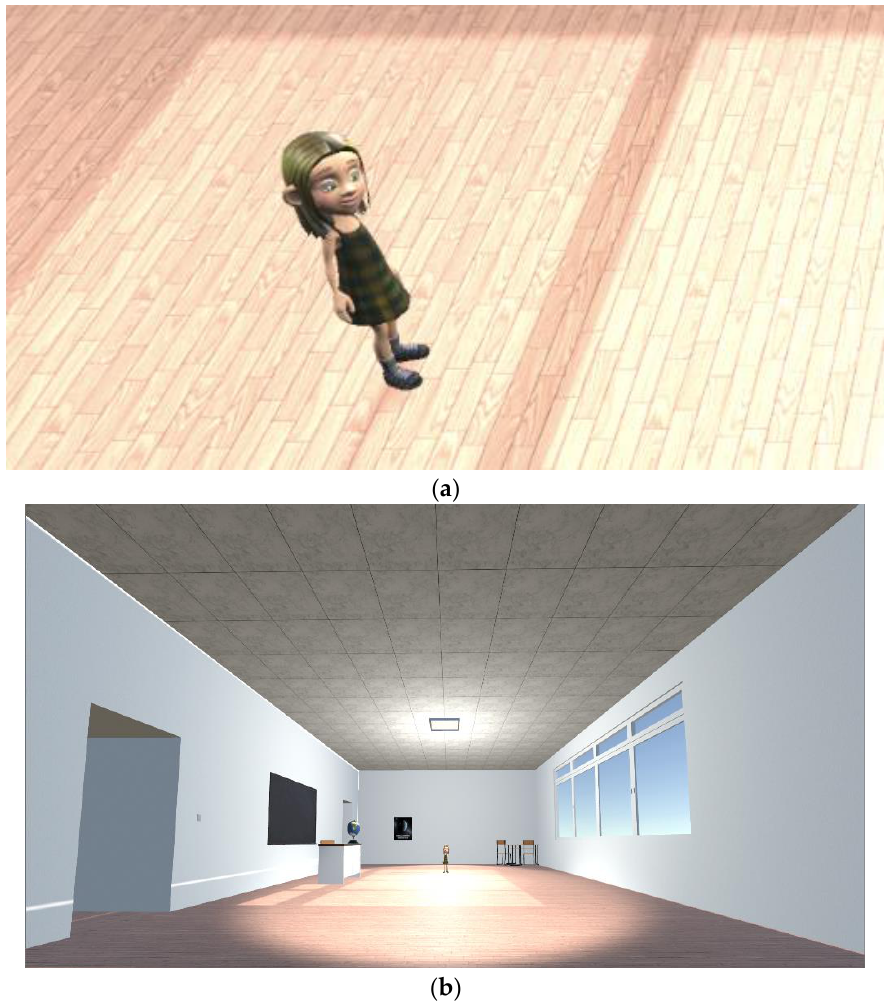
Figure 1. Snapshots of the VR session environment and avatar. ( a , b ) display a close-up and a broader view of the environment and avatar in the VR session, respectively.